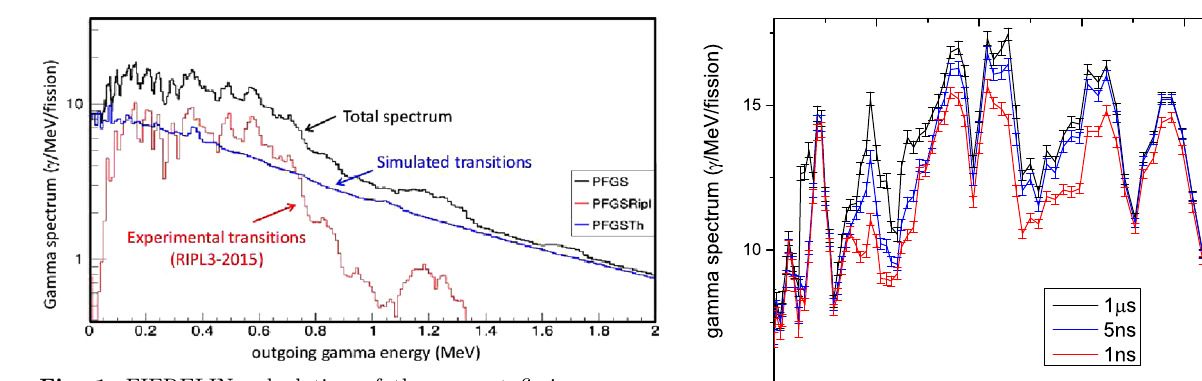
Fig. 1. FIFRELIN calculation of the prompt fi ssion gamma spectrum of 252 Cf(sf) reaction. Total spectrum, simulated part from level densities and photon strength functions and simulated part from gamma-ray intensities provided by database are shown as black, blue and red histograms, respectively. Fig. 2. In